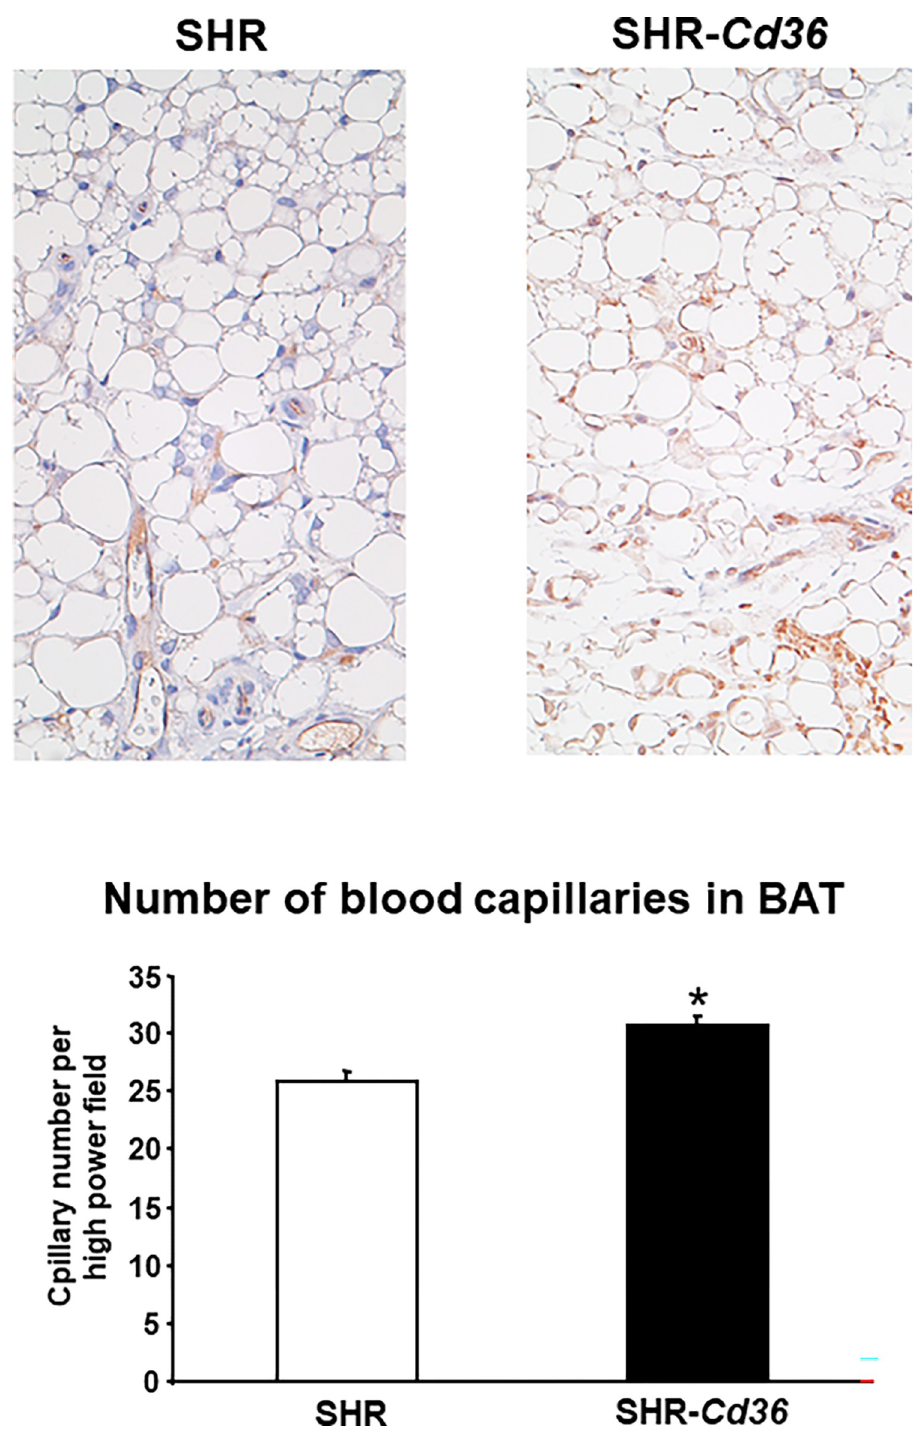
Fig 4. Capillary number in BAT was significantly increased in SHR- Cd36 versus SHR rats. * denotes P < 0.003.